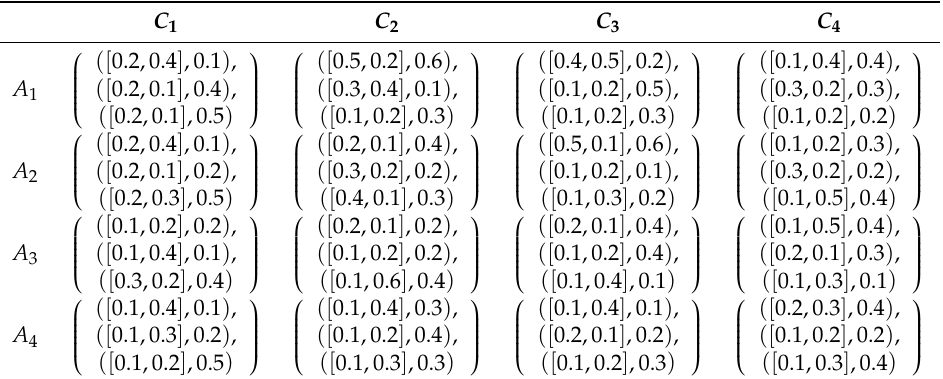
Table 1. First decision-maker data.